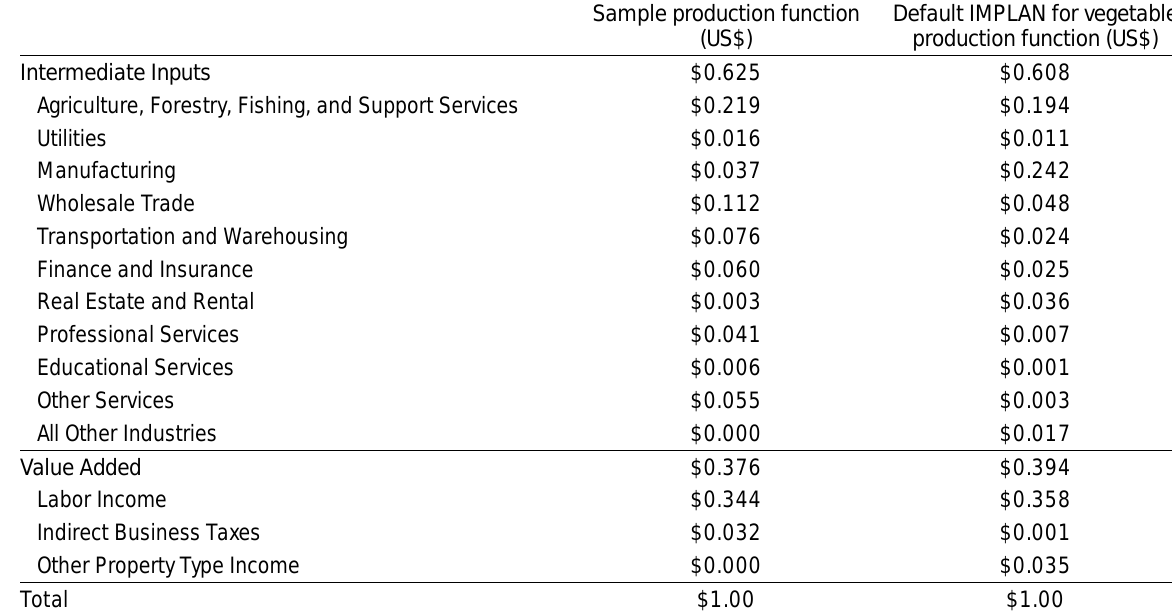
Table 1. Purchases per Dollar of Sales, Sample Production Function vs. Default Production Function for Central Region of